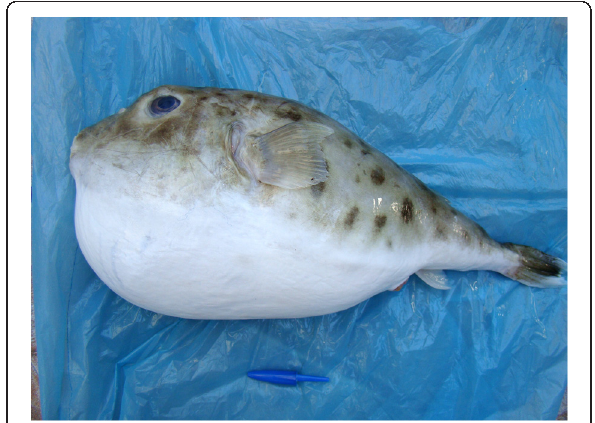
Figure 1 A specimen of the genus Sphoeroides , the spotted puffer fish or baiacu-pinima (in Portuguese). This genus is associated with most poisonings in